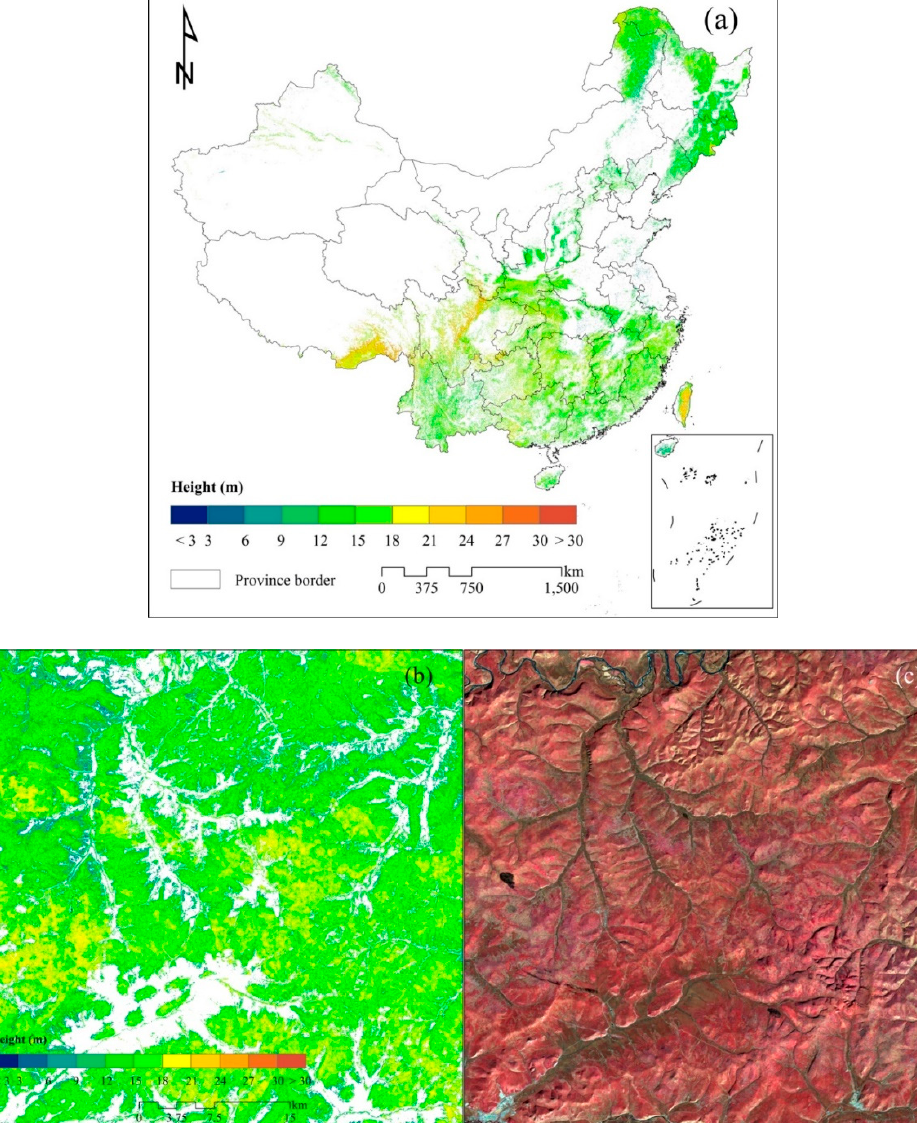
Figure 5. Spatial patterns of forest heights in China ( a ). ( b ) is a subset in Greater Xiang’an Mountains that centered at 53.09°N, 123.19°E to show detailed height distribution and ( c ) corresponds to Landsat image (near infrared (NIR) – Red – Green).